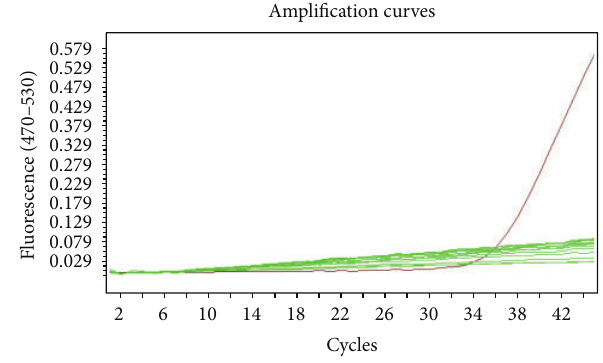
Figure 1: Application curves for meristem